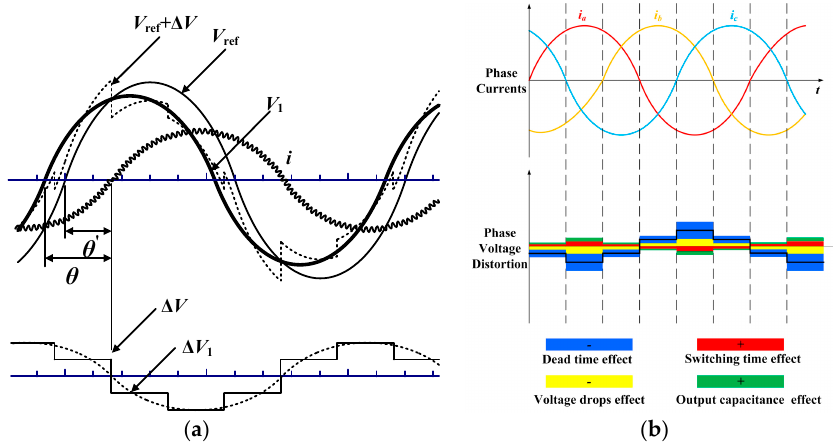
Figure 5. The voltage distortion and its impact on current. ( a ) Representation of waveforms of the voltage and current; ( b ) Average voltage distortion induced by four aspects.